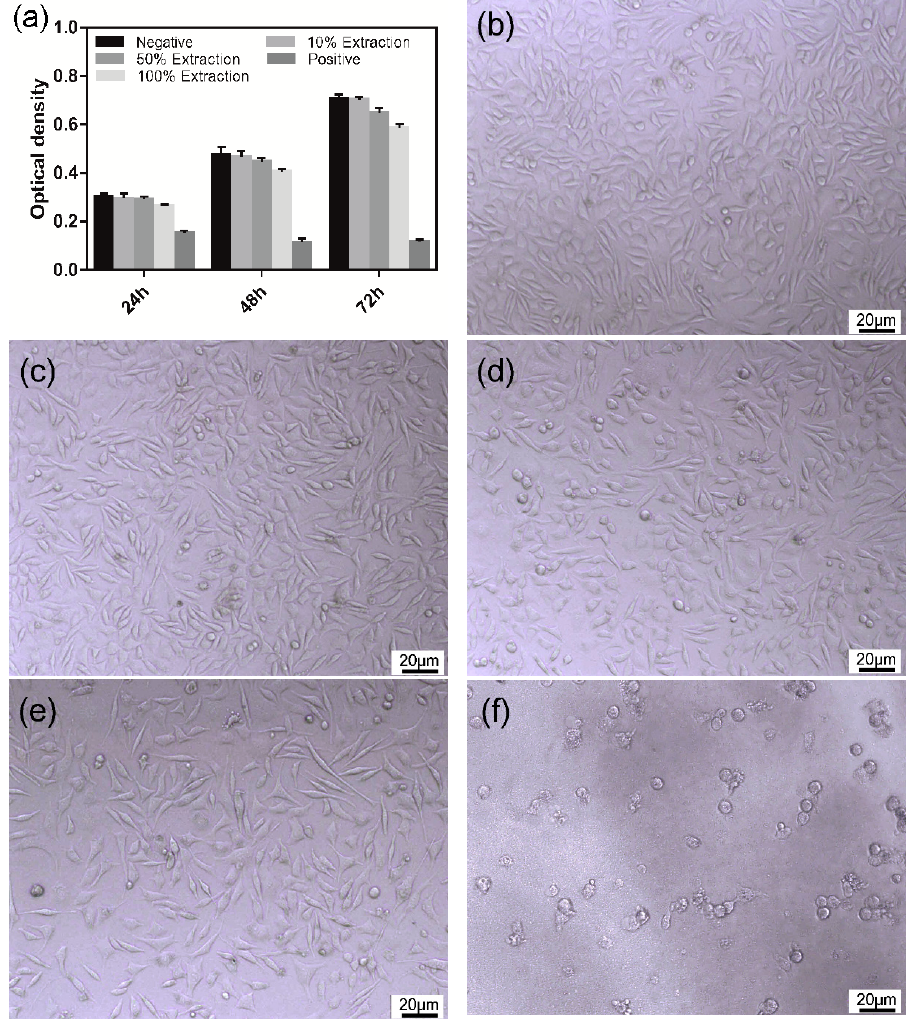
Figure 9. Cytotoxicity results of the Ex ‐ Mg ‐ 4Y ‐ 1Ag alloy: ( a ) Optical value (OD) of L ‐ 929 cells cultured in different extracts. Optical images of L ‐ 929 cells that cultured in ( b ) negative control (complete medium); ( c ) 10% extracting liquid; ( d ) 50% extracting liquid; ( e ) 100% extracting liquid; and ( f ) positive control (0.5% phenol) at 72 h.